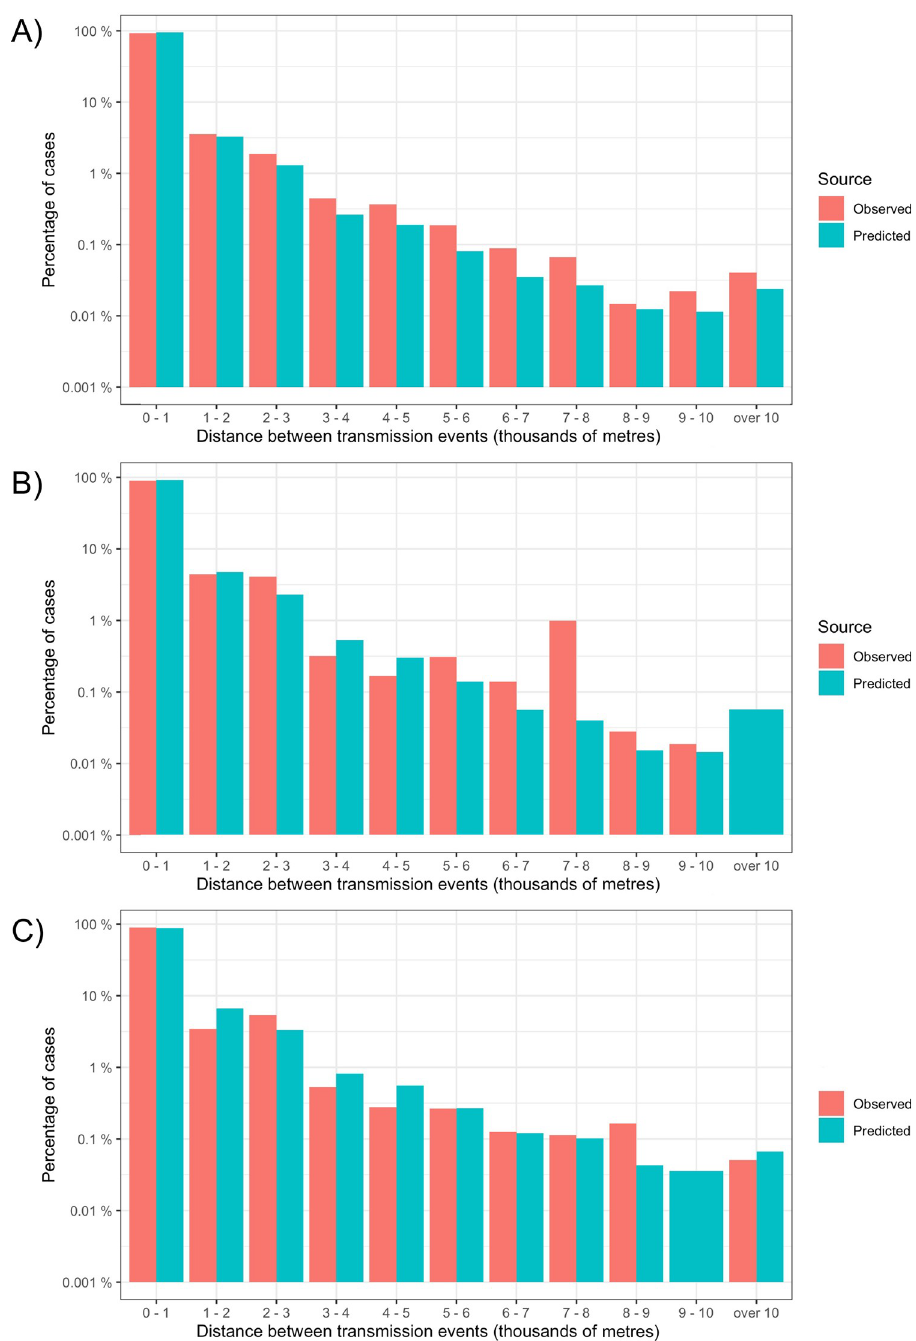
Fig 5. Comparison of the spatial transmission kernels of observed cluster data and model predictions. These histograms show the observed and model predicted distances between detected cases in the current week and cases two weeks (approximately one serial interval) ahead. Case distances are calculated as Euclidian distance to nearest neighbour with case location assigned to the midpoint of a 1km x 1km grid. Model predictions show the median of 10 runs from the best fitting human movement model (gravity for A and B, exponential for C). Number of cases shown on a log10 scale for cluster 1 (A), 2 (B) and 3 (C).